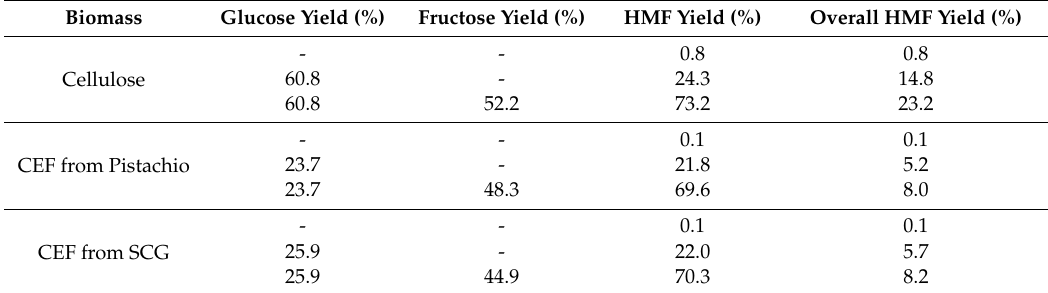
Table 8. Summary of the cellulose / CEF hydrolysis, glucose isomerization and fructose